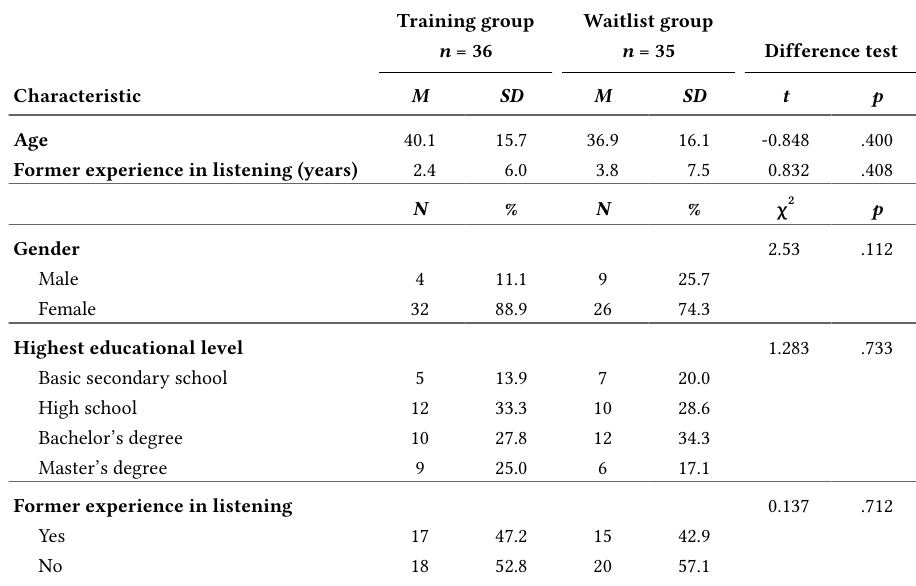
Descriptive Characteristics for the Training and Waitlist Group